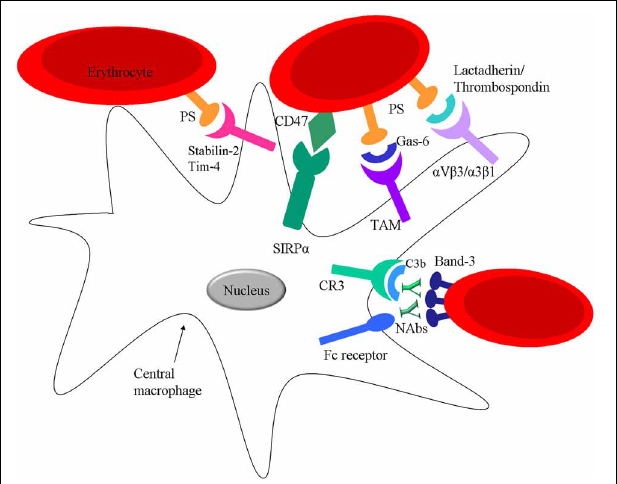
FIGURE 4 | Interactions between mature RBC and spleen macrophages. RBC can interact with spleen macrophages via direct receptor ligand pairing or via bridging molecules. Ageing RBC express PS on their surface which can directly bind to Stabilin-2 or Tim-4 on the macrophage or via opsonins such as Gas-6, lactadherin or thrombospondin-1. RBC express CR1 on their surface which can bind C3b osponized particles and further facilitate interaction with spleen macrophages via CR1 and CR3. Nabs can bind Band-3 on the surface of RBC targeting the cell for clearance via Fc receptors on the spleen macrophages. Moreover, RBC express CD47 which binds SIRP α on